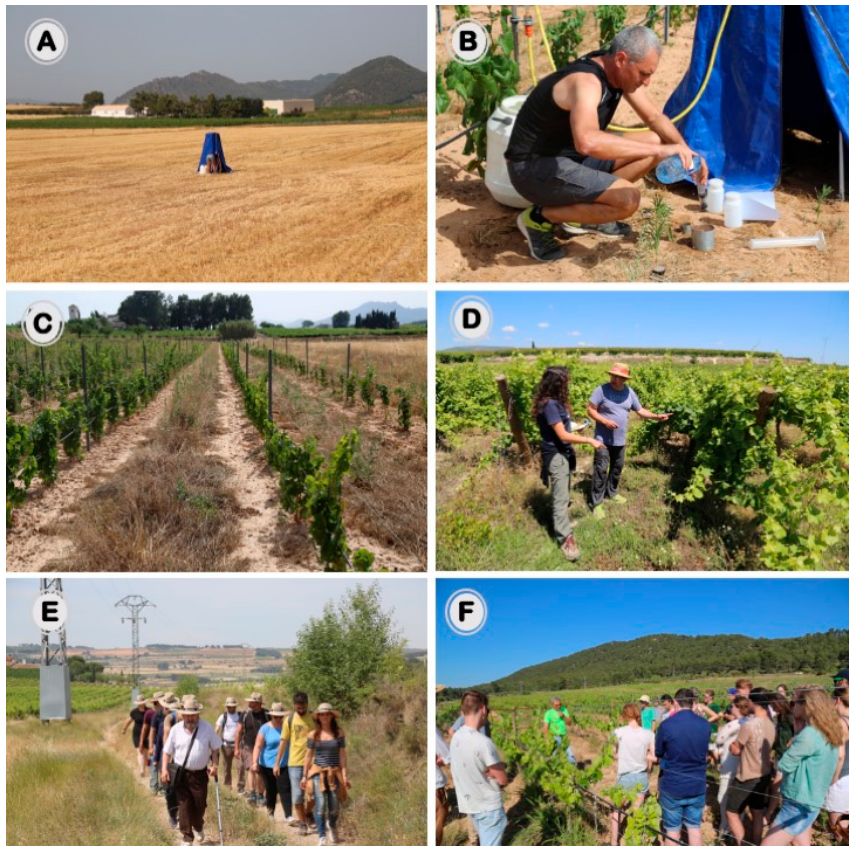
Figure 8. Pago Casa Gran is a lighthouse farm as they produce different agriculture products under organic farming ( A ), and allow research to be conducted in their farm ( B ) with the use of catch crops ( C ) under the supervision of scientists ( D ); Dr Agata Novara and the Pago Casa Gran technicians) and they complement their management with the visit of scientists, farmers, and students ( E , F ). ( E ), show scientists from the different research stations at the Pago Casa Gran (Dr. Ramon Bienes at the forefront to the left in E) and also students such as the ones from the University of Wageningen attending the lecture of Artemi Cerdà, recently.